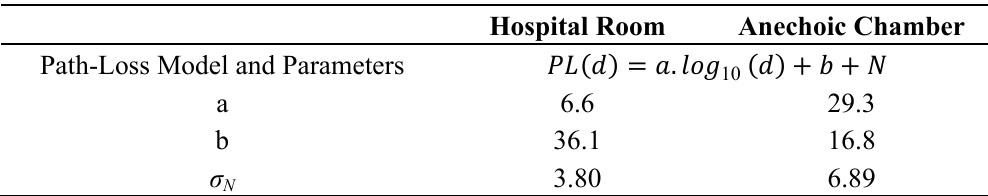
Table 5. Proposed Channel Model for NB